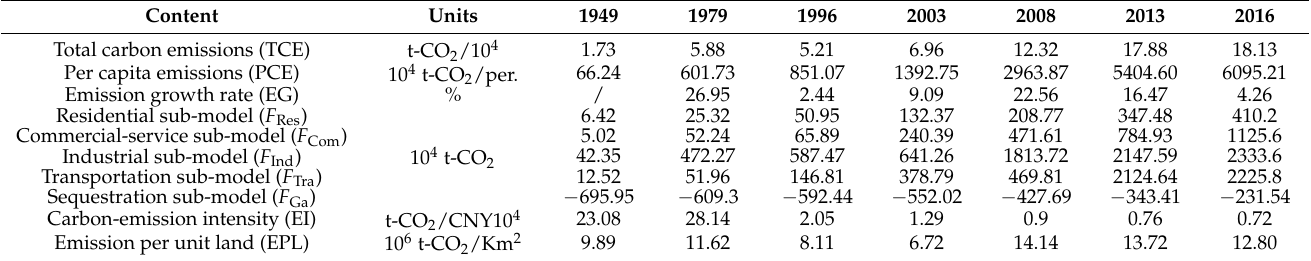
Table 5. Carbon emission prediction of